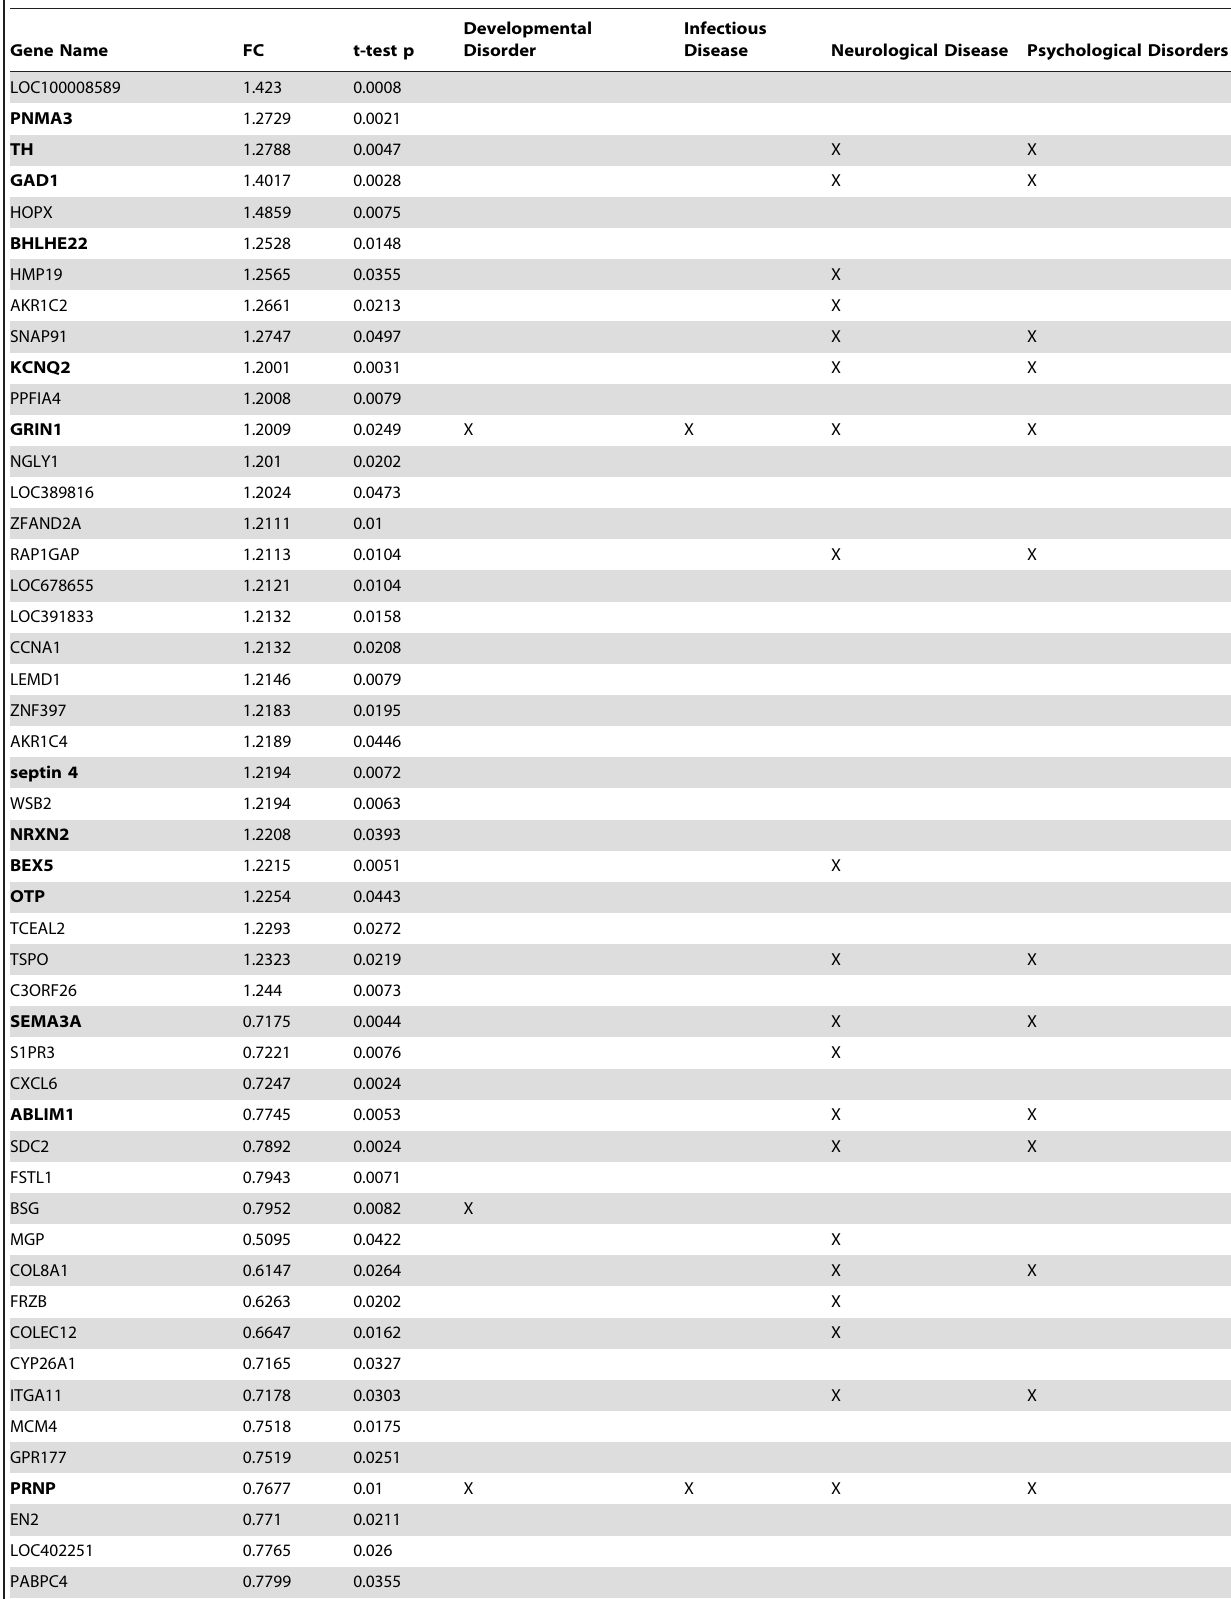
Table 1. Significant gene expression changes following HCMV infection of neural progenitor